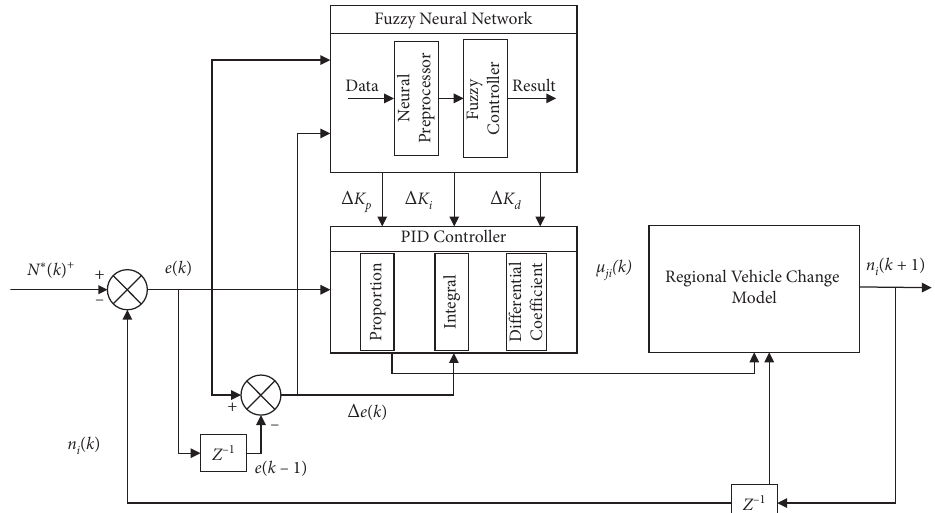
Figure 8: Area boundary control